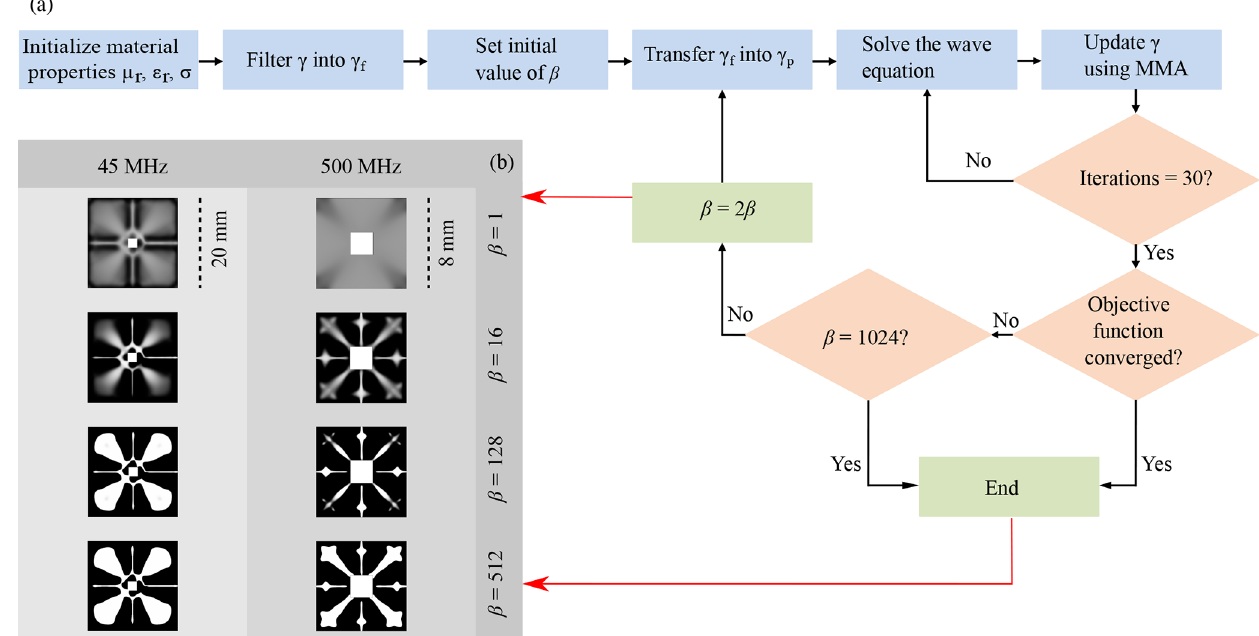
Figure 3. (a) Flowchart representing the workflow followed to obtain the material distribution. (b) Intermediate results obtained during the optimization process for different values of frequencies, and projection slope ( β ). The material distribution was plotted on a greyscale such that 0 (white) represents air and 1 (black) represents Cu. The final optimization result was obtained at β = 512 for the designed